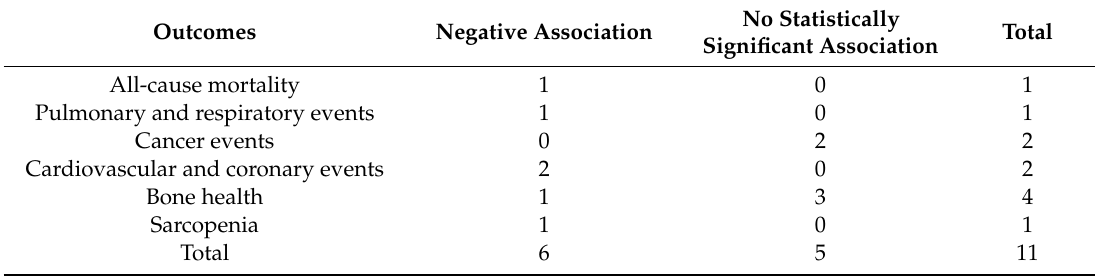
Table 4. Number and direction of associations between 1.25(OH)D and outcomes selected. Negative (or inverse associations) are those representing an increased risk of event incidence at follow-up with the decrease of 25(OH)D levels at baseline; the second column reports non-statistically significant associations between 25(OH)D levels at baseline and risk of an event at follow-up. No Statistically Total Outcomes Negative Association Significant Association All-cause mortality 1 0 1 Pulmonary and respiratory events 1 0 1 Cancer events 0 2 2 Cardiovascular and coronary events 2 0 2 Bone health 1